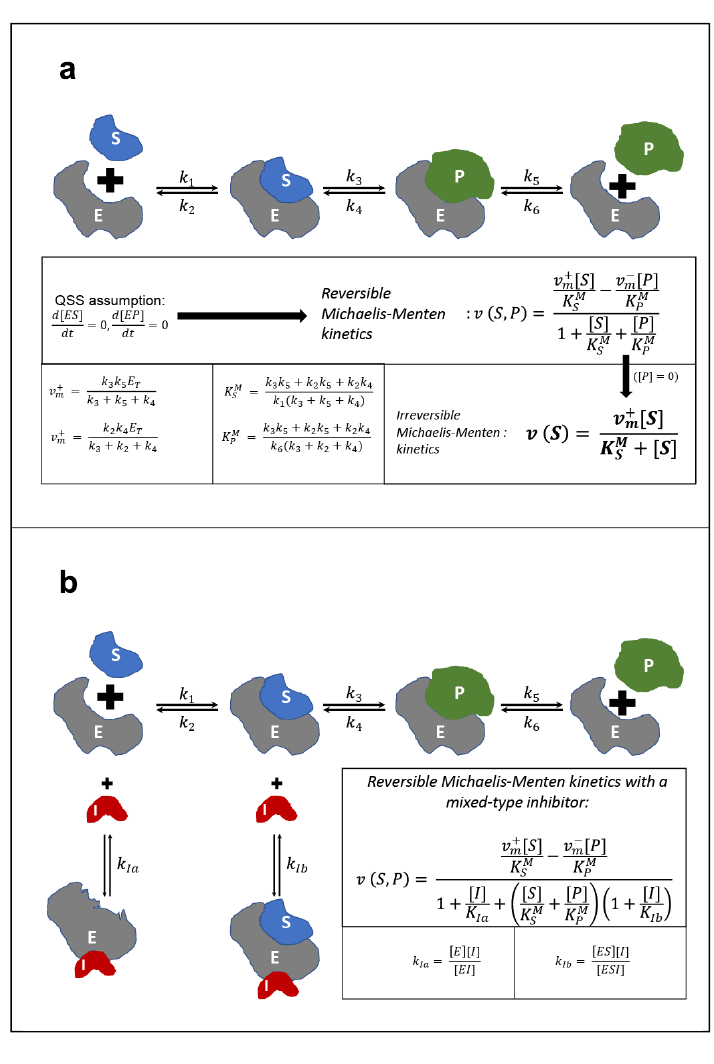
Figure 7. Michaelis-Menten enzymatic reaction mechanism. ( a ) Substrate S is converted to product P through an enzymatic reaction catalyzed by the enzyme E. ( b ) The inhibitor I is introduced and inhibits both the enzyme and enzyme-substrate